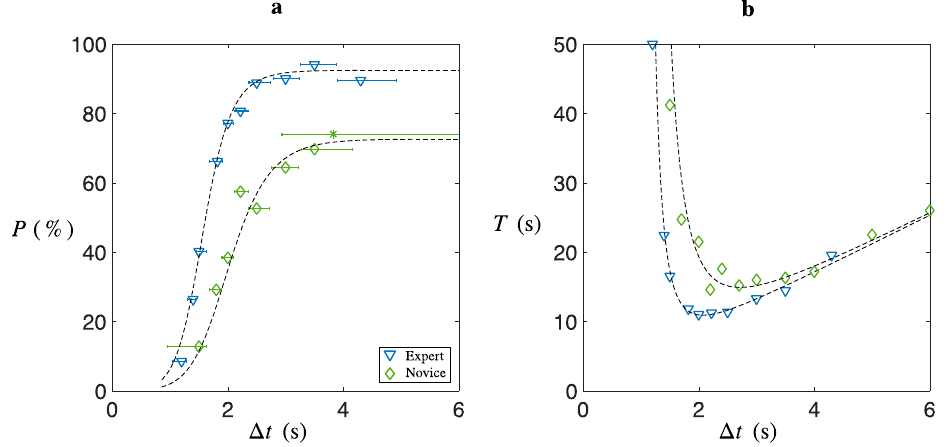
Figure 3. Speed accuracy trade-off and total time spent at the shooting range. ( a ) Evolution of accuracy with shooting time. The blue triangles represent the result of an elite pentathlete located 10 m from the target, while the green diamonds are obtained with a shooter with no experience in shooting, located 4 m from the same target. For each metronome’s cadence, the horizontal error bar represents the interval of real shooting times taken by the shooter. The dashed black lines represent the best fits obtained by Equation (3). ( b ) Total time spent at the shooting range with shooting time of the same two persons. It corresponds to the time needed by the subject to succeed 5 shots. The black dashed lines are given by Equation